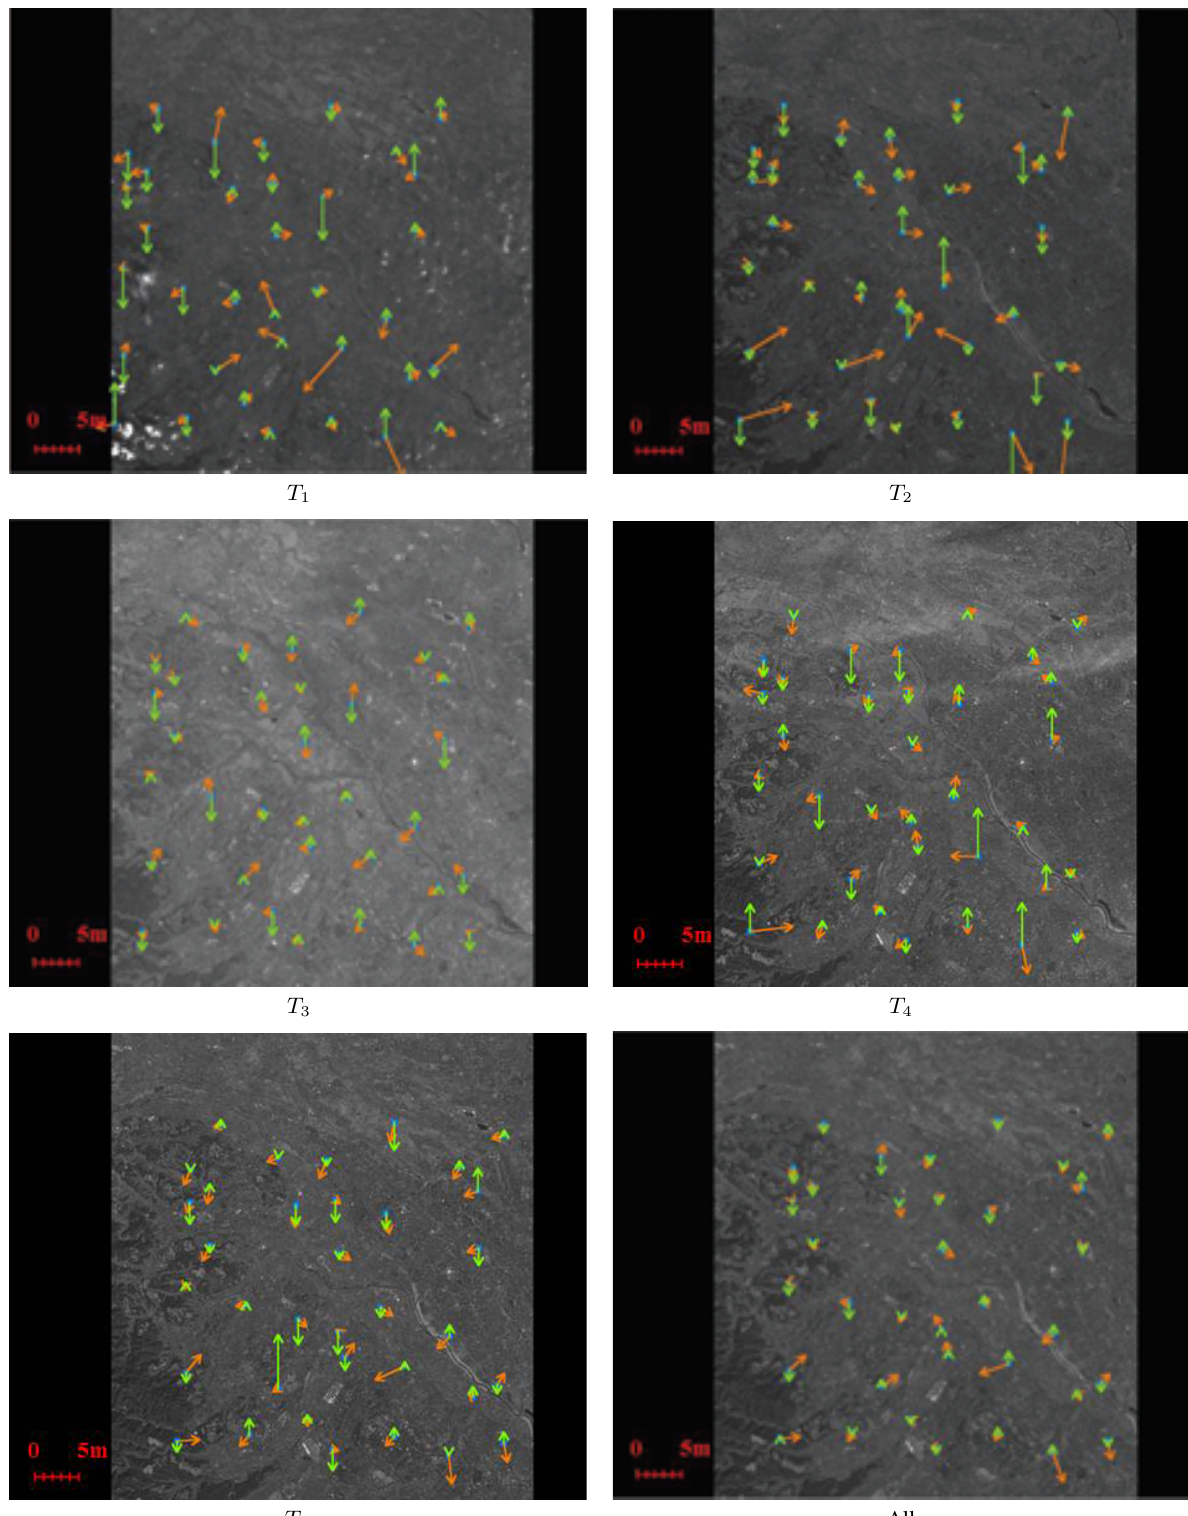
Figure 2. RMSE of coordinates estimated by using the bias-corrected RPC model. Brown and green arrows denote planimetric and height errors,